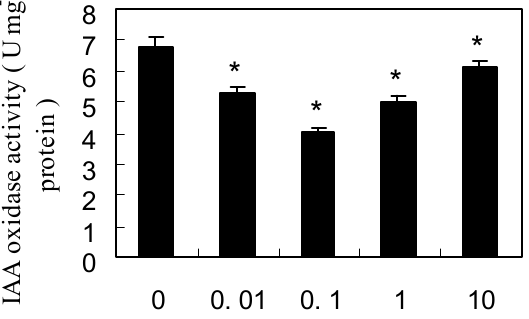
Figure 3. Effects of Fe-chlorophyllin on the activity of IAA oxidase in the root of wheat. Seeds of wheat were soaked in the same culture solution containing 0, 0.01, 0.1, 1 and 10 mg/L Fe-chlorophyllin for 12 h and then transferred to the quarter-strength Hoagland’s nutrient solution containing different concentrations of Fe-chlorophyllin for four days after germination. Vertical bars represent standard deviation of the mean ( n = 3). Asterisks indicate that mean values are significantly different between the treatment and control ( p <